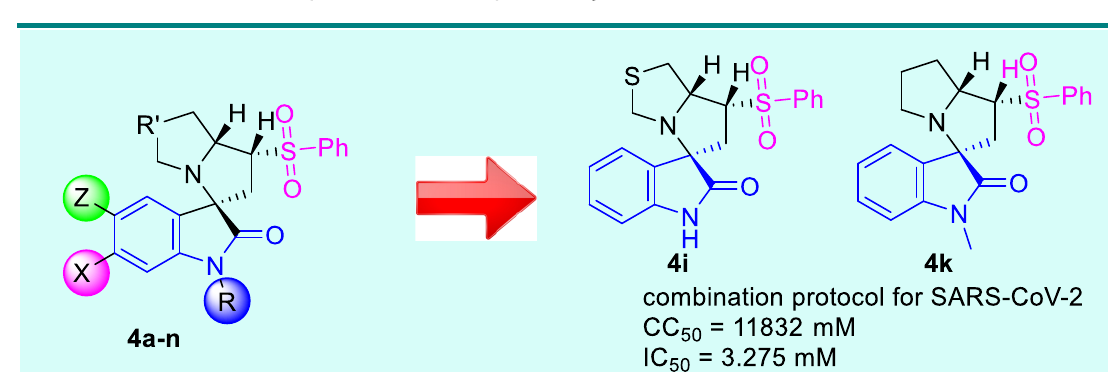
Figure 1. Representative examples of indole-derived moieties with pharmacological applications and our designed compounds as anti-viral drug for SARS-CoV-2.